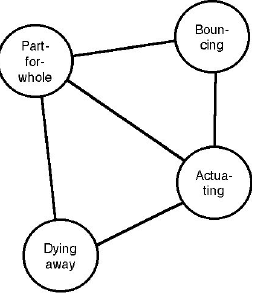
FIG. 1. Example resource graph. Individual resources are circled and connected to each other